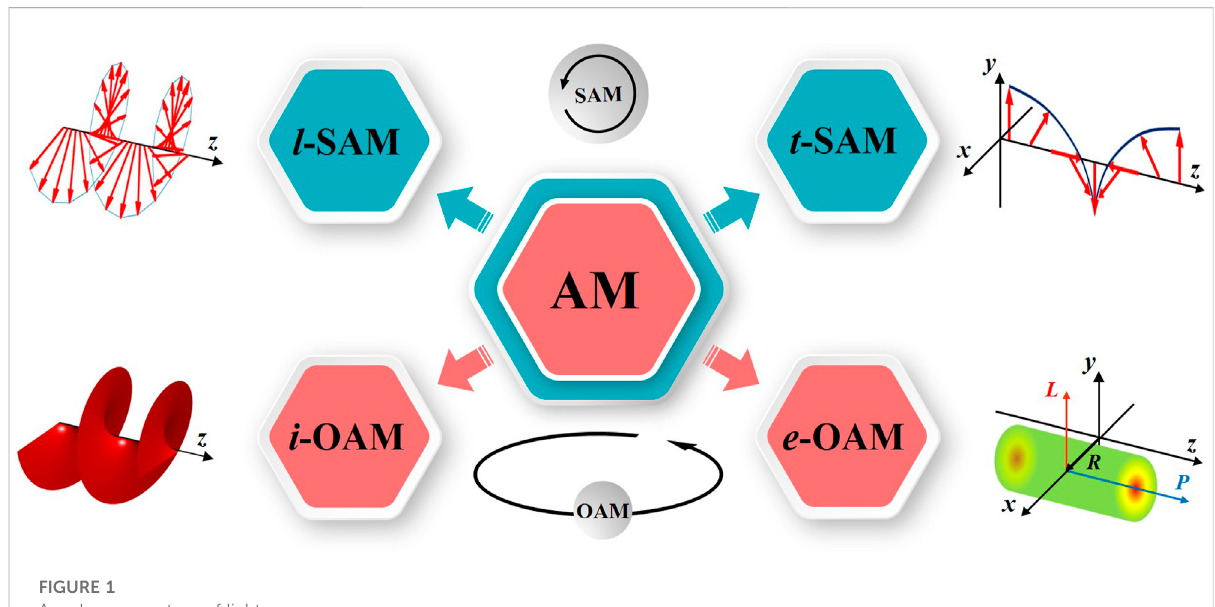
FIGURE 1 Angular momentum of